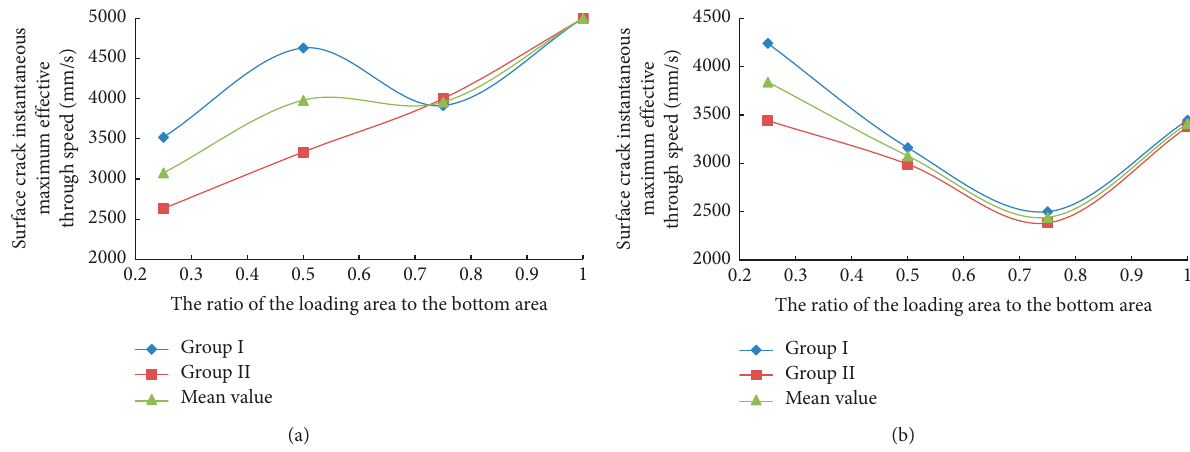
Figure 12: Instantaneous maximum effective cut-through rate of surface cracks (unit: mm/s). (a) Coal samples; (b) briquette